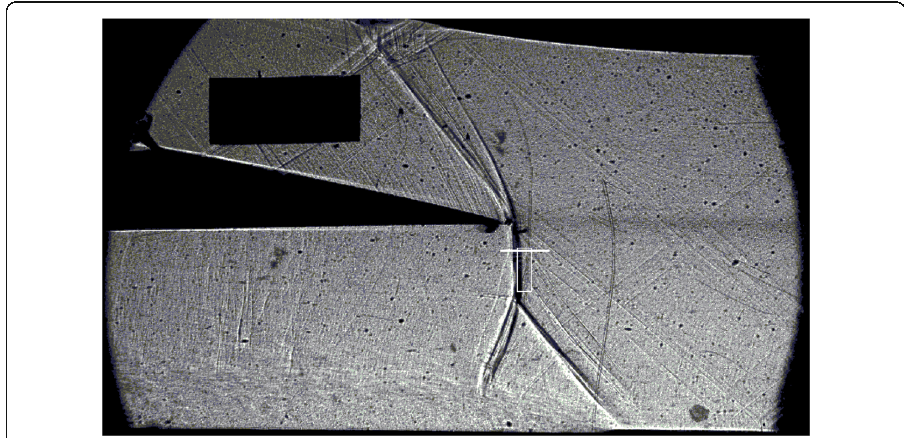
Fig. 12 Shadowgraph flow visualization image, where short horizontal white line indicates pixel locations where the grayscale data are analyzed to obtain results given in Fig. 13, and where white rectangle indicates pixel locations where grayscale data are analyzed to obtain the ensemble-averaged results given in Fig. 14, for data acquired on 05 April